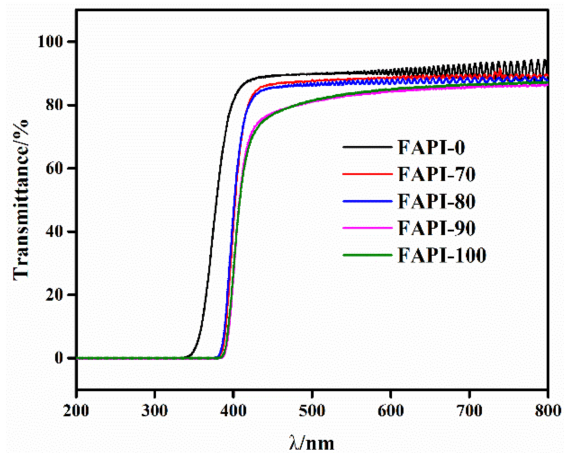
Figure 4. Ultraviolet-visible (UV-vis) spectra of the FAPI films with different biphenyl content in polymer